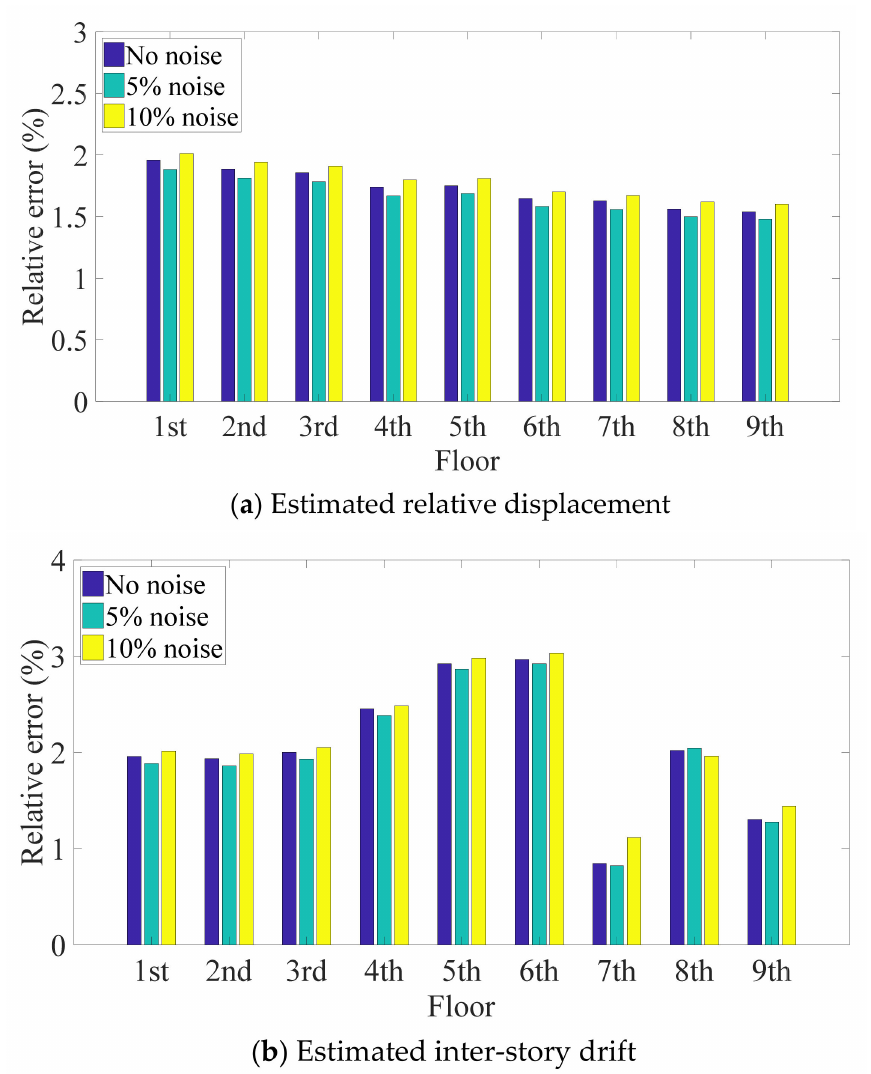
Figure 8. Relative maximum error of nine-DOF structure for different noise